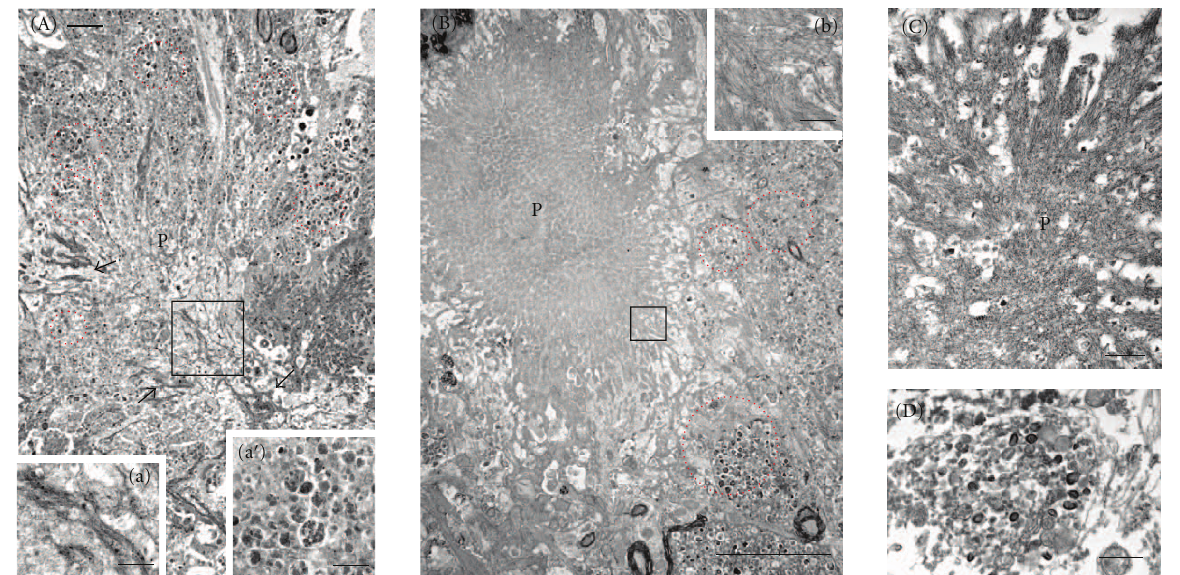
Figure 13: Electron microphotographs showing neuritic plaques (p) surrounded by numerous dystrophic neurites (dotted-red circles) in tissue sections through the hippocampal-subicular complex of a 9-(A) and 23-(B) month-old 3xTg-AD female mouse. Boxed area (a) shows details of the fibrillar material from amyloid plaque in A. a (cid:4) shows an example of a dystrophic neurite from a 9-month-old 3xTg-AD containing electron-dense multilaminar, multivesicular, and dense-core bodies similar to that seen in the cortex of a patient with AD (D). Note that at 23 months of age neuritic plaques show an electron dense center core (B) with numerous fibrillar branches (b) similar to a neuritic plaque seen in AD (c). Abbreviation: n: nucleus. Scale bars: A = 2 μ m, B = 5 μ m, C, a, b = 0.5 μ m, and D, a (cid:4) = 1 μ